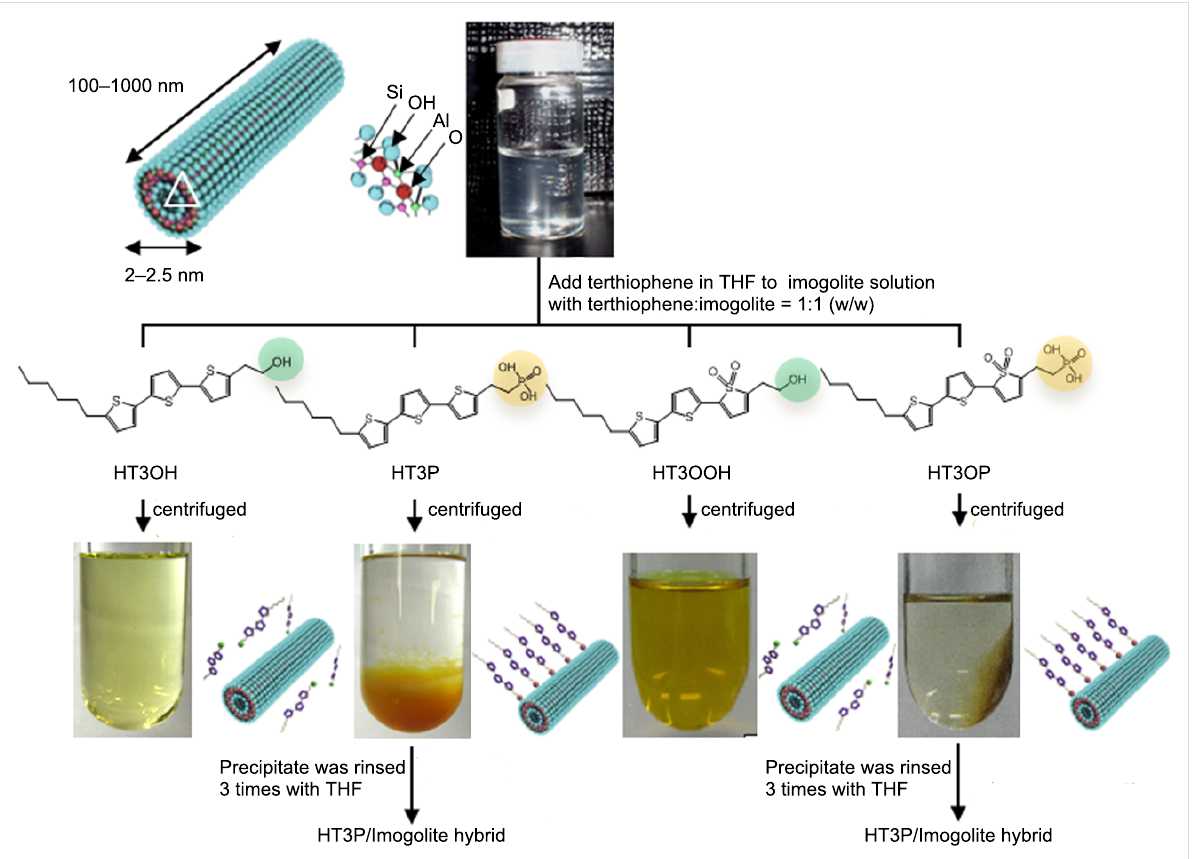
Figure 15: Schematic illustration of imogolite structure and the preparation of terthiophene/imogolite hybrid materials. Reprinted with permission from W. O. Yah et al., Bull. Chem. Soc. Jpn. 2011, 84, 893–902 [60]. © 2011, The Chemical Society of Japan.